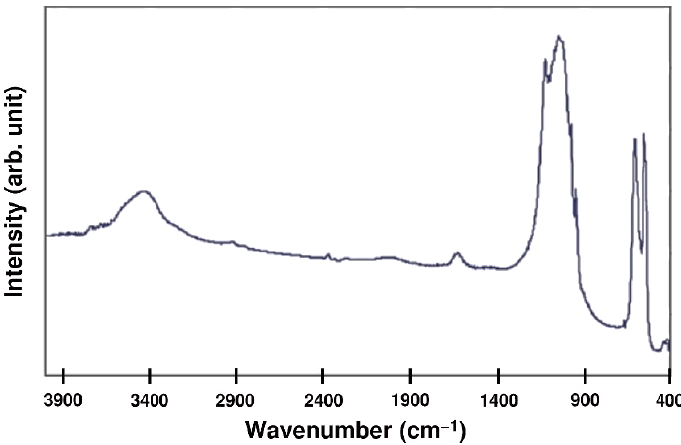
Figure 8. FT-IR spectrum of β -TCP. Reprinted and adapted with permission from Ref. [115]. Copy- right 2017 Elsevier Masson SAS. All rights reserved.